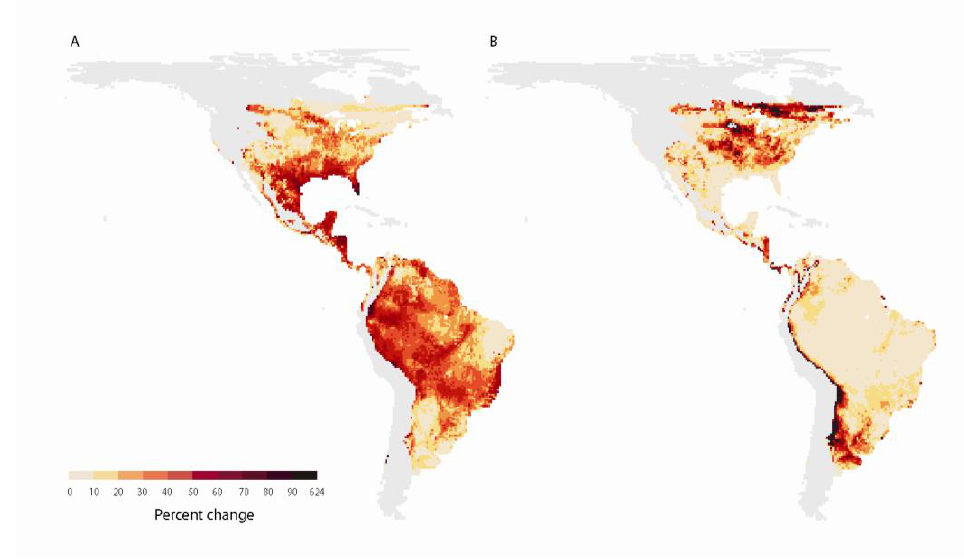
Figure 2. Predictions of (A) losses and (B) gains in amphibian species as a result of potential climate-driven shifts in species distributions. Predictions were based on 10 different climate projections for a mid-high (A2) greenhouse-gas emission scenario. Eighty percent (8 of 10) of the climate-change projections resulted in greater percent losses (A) and gains (B) in species richness than the values in these maps. The light grey areas indicate where small sample sizes precluded reliable estimates of change. These data and analyses are described in full in Lawler et al .